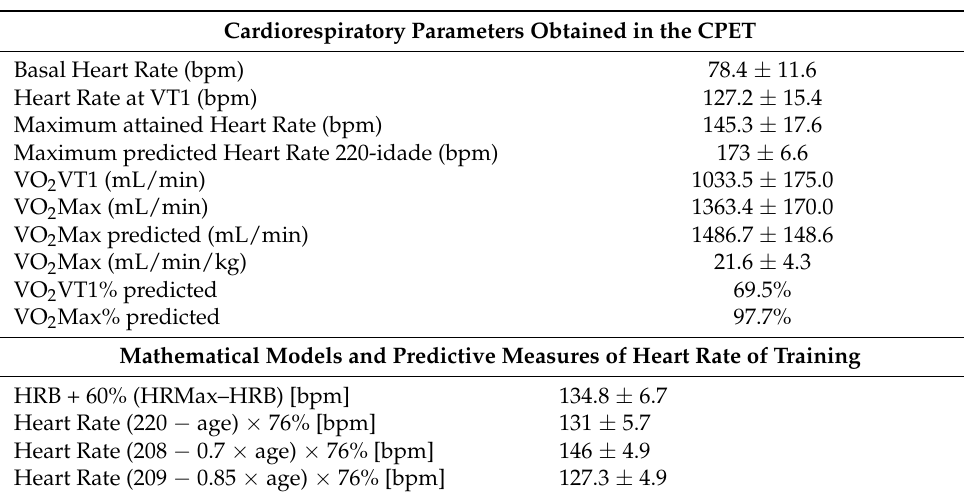
Table 1. Cardiorespiratory parameters obtained in the CPET and predictive measures of heart rate of training by mathematical models of women with fibromyalgia. Cardiorespiratory Parameters Obtained in the CPET Basal Heart Rate